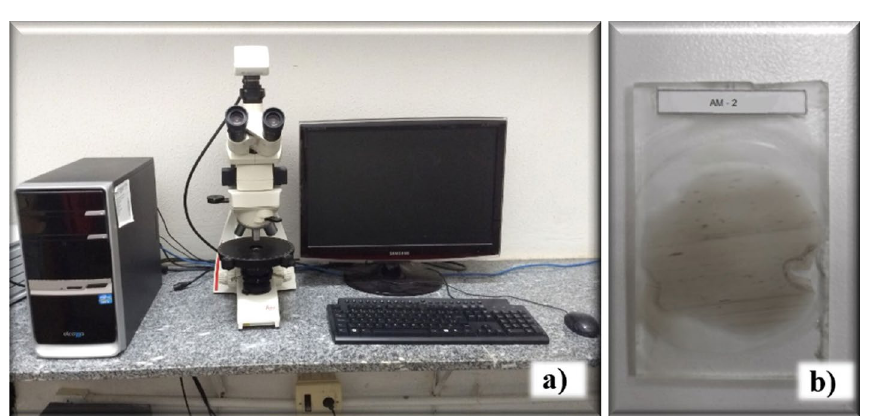
Figure 7. Microscopy procedure using thin slides. ( a ) Thin slides and ( b ) petrographic